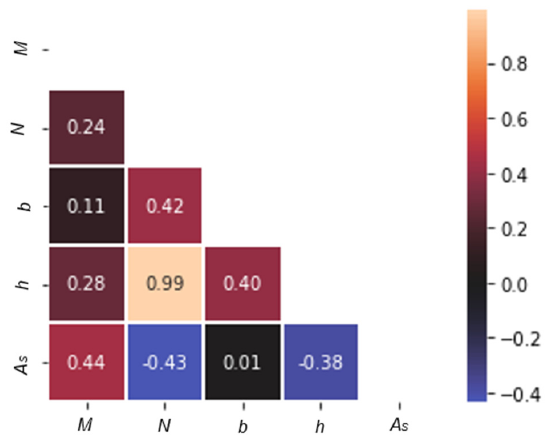
Figure 4. Visualization of the correlation matrix between input and output variables.